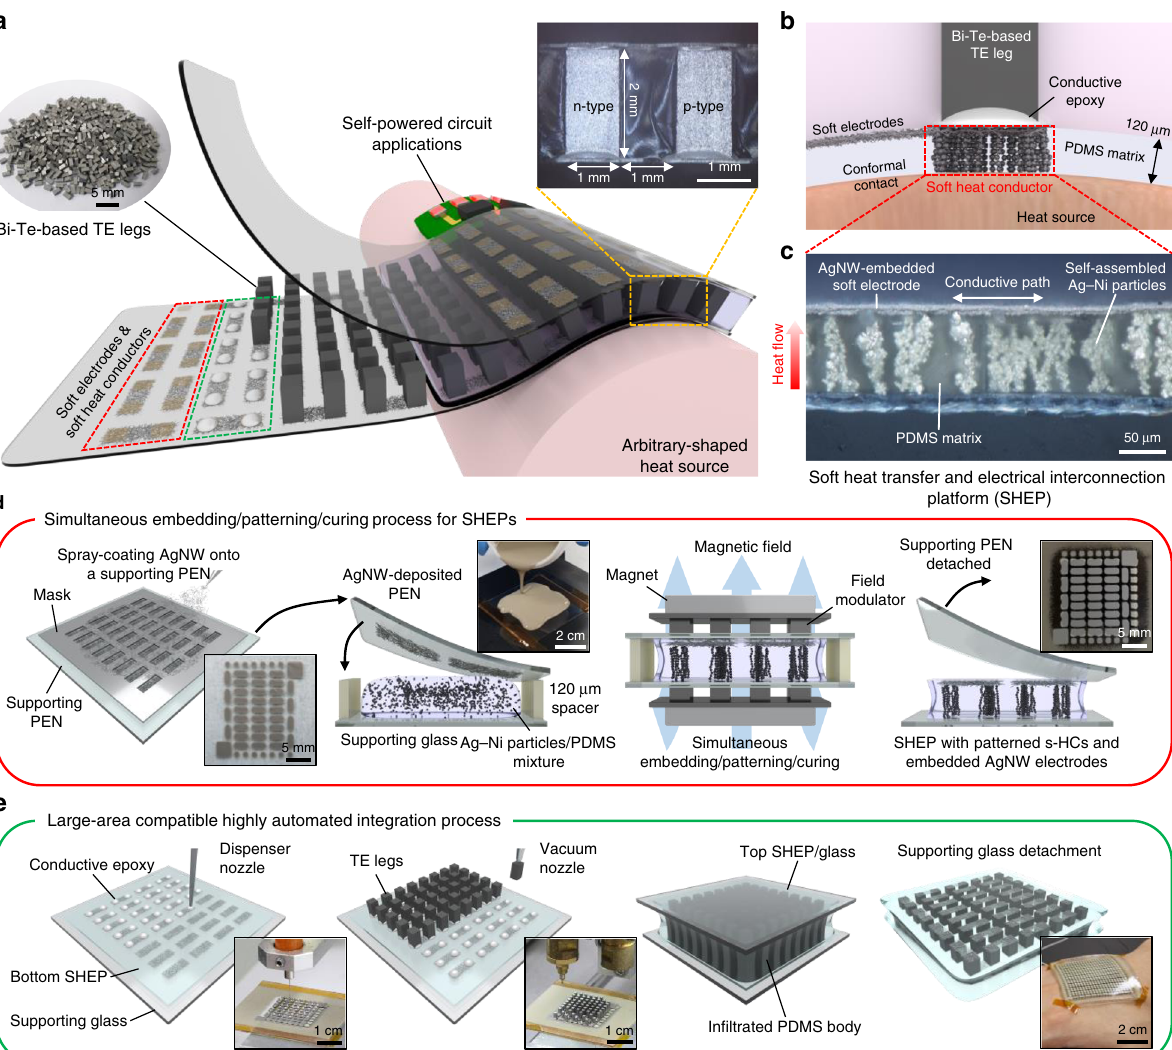
Fig. 1 Design and fabrication process for compliant thermoelectric generator (TEGs). a Conceptual illustration of a compliant TEG with soft electrodes and soft heat conductors (s-HCs) for self-powered circuit applications. The left inset is a photograph of bismuth telluride (Bi 2 Te 3 )-based thermoelectric (TE) legs and the right inset is an optical image of a cross-section of the compliant TEG. Scale bars, 5 and 1 mm. b Schematic illustration showing the structure of the compliant TEG establishing conformal contact with an arbitrary-shaped heat source. The s-HCs ef fi ciently transfer heat energy from the heat source to the TE legs, and the soft electrodes allow a high degree of mechanical freedom. c Microscopic image of the soft heat transfer and electrical interconnection platform (SHEP) with embedded soft silver nanowire (AgNW) electrodes and patterned silver-coated nickel (Ag – Ni) s-HCs. Scale bar, 50 μ m. d Schematic illustration and photographs of simultaneous embedding/patterning/curing process for the SHEPs. Scale bars, 5 mm, 2 cm, and 5 mm. e Schematic illustration and photographs of a large-area compatible fully automated integration process using a programmable dispenser and a pick-and- place machine. The rightmost photograph shows a compliant TEG comprising 440 TE legs conformably attached to human skin. Scale bars, 1